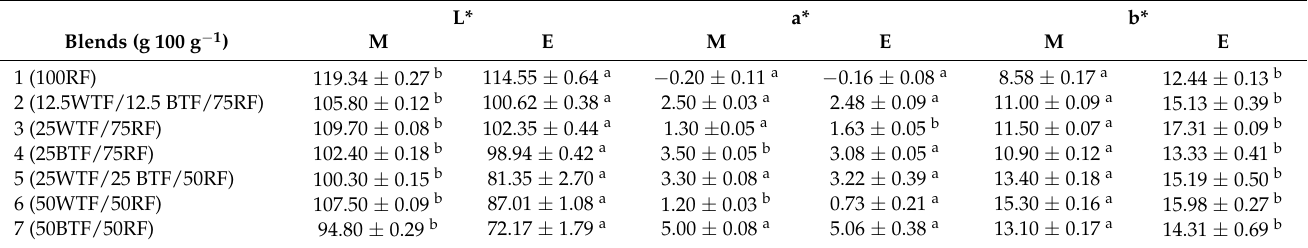
The a * (green to red) colour parameter significantly changed in some of the blends, Different letters indicate significant differences ( p < 0.05) between non-extruded (M) and extruded (E) although a not clear trend was observed; meanwhile, b * (blue to yellow) showed signifi- flours, for each blend formulation and colour parameter. M1/E1(100RF), M2/E2 (12.5WTF/12.5 BTF/75RF), cant increase in all the formulas, indicating a higher yellow component in the colour of the extruded samples.